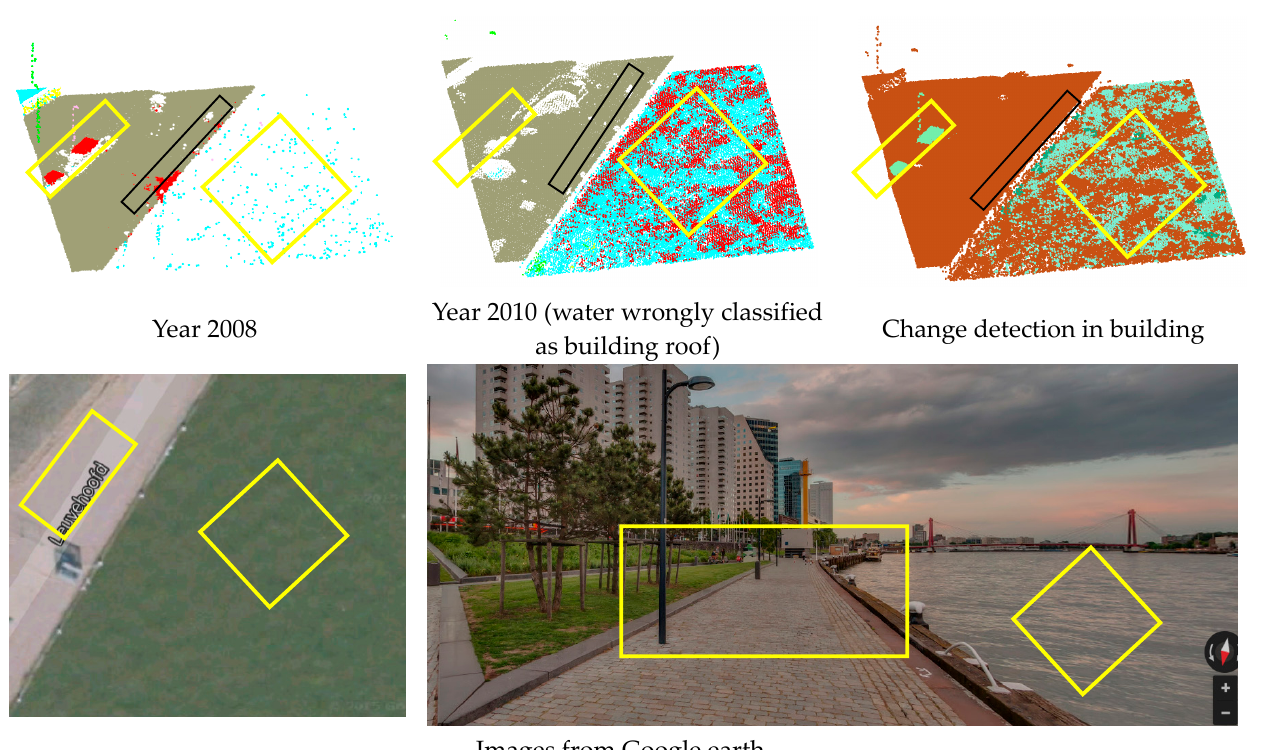
Figure 14. Scene classification errors that have no influence on the change detection results (black rectangles), and ones that have a negative influence (yellow rectangles).